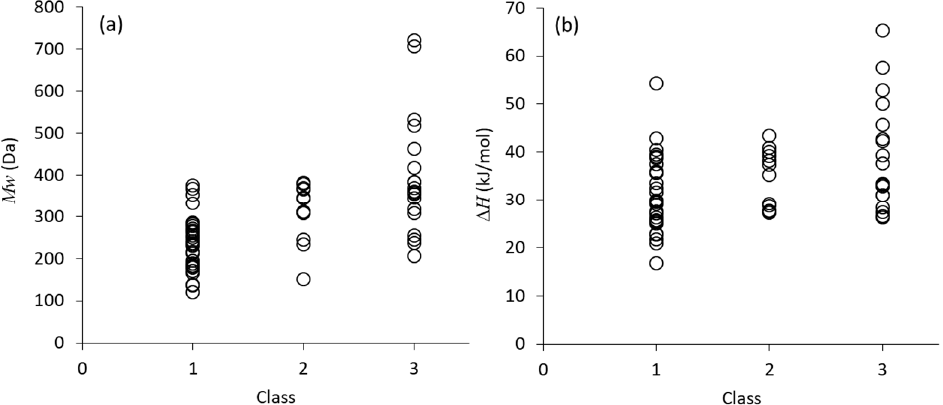
Figure 3. Visualization of: ( a ) molecular weight; and ( b ) melting enthalpy of compounds belonging to each class.